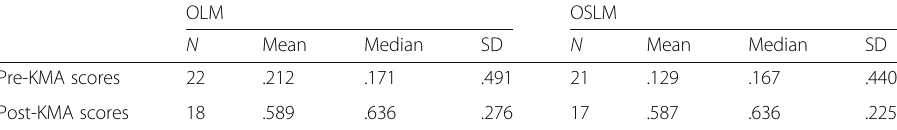
Table 5 KMA mean, median, and standard deviation scores for the OLM and OSLM groups